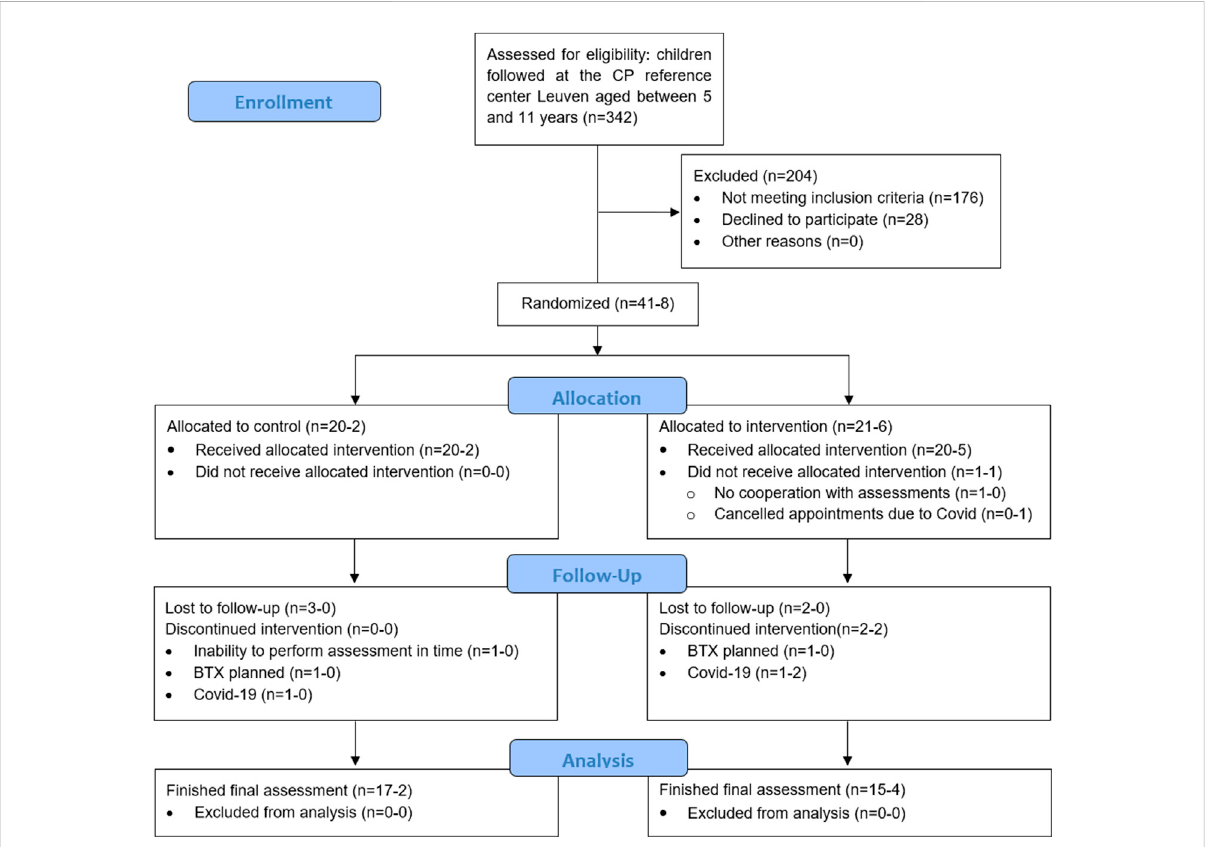
FIGURE 1 All children aged 5 – 11 years old were extracted from the clinical database of the CP reference center Leuven ( n = 342) and screened based on gross motor function classi fi cation system level and type of CP. The scheduled appointments at the children ’ s hospital and gait laboratory were monthlycheckedtofurtherscreenpotentialparticipantsbasedontheexclusioncriteria(±10%eligibleeverymonth,partofthe n =342).Additionally, pediatric physiotherapists at private practices and special needs schools were consulted for potential participants resulting in 6 of the 49 participants not being followed up in Leuven. The fi rst number, before the hyphen, represents the participants that were randomized by minimization by Minim-Py before the forced stop of the study due to the global Covid-19 pandemic, the number after the hyphen represents the participants who were manually minimized afterwards. *Included in primary analyses: control group=22 and intervention group=26 (1 randomized child did not participate in baseline assessments). Included in sensitivity analyses: (cid:129) Randomized: control group=20 and intervention group=20 (1 randomized child did not participate in baseline assessments).